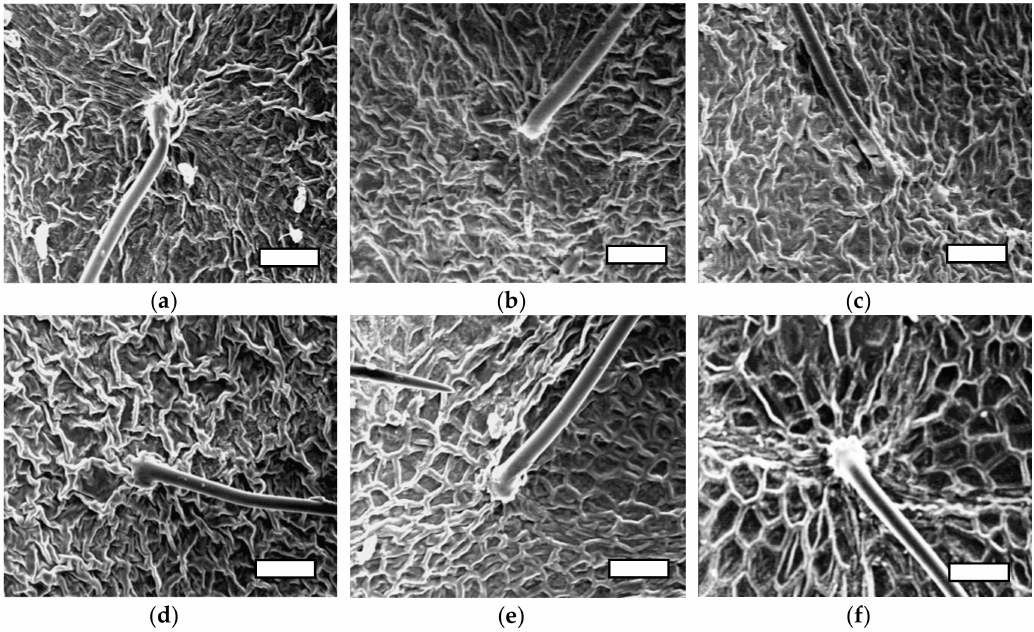
Figure 3. The e ff ects of salt stress and nSiO 2 on the epidermal cell walls of strawberry leaves. ( a ) Cont; 0 mM NaCl + 0 mg L − 1 nSio 2 , ( b ) 0 mM NaCl + 100.50 mg L − 1 SiO 2 ( c ) 25 mM NaCl + 0 mg L − 1 SiO 2 ( d ) 25 mM NaCl + 100,50 mg L − 1 SiO 2 , ( e ) 50 mM NaCl + 0 mg L − 1 SiO 2 , ( f ) 50 mM NaCl + 100.50 mg L − 1 SiO 2 . Scanning electron microscope (SEM) image of the strawberry leaves. White scale bars = 100 µ